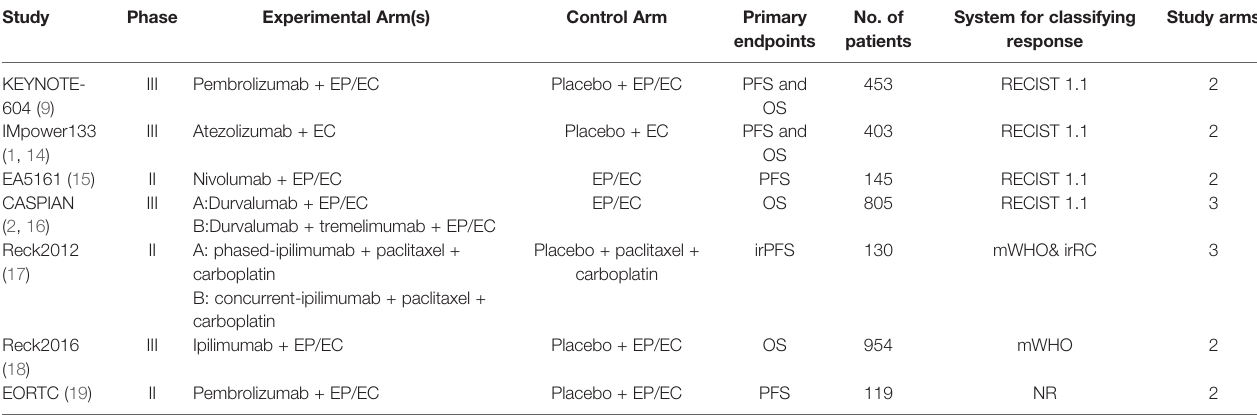
TABLE 1 | Basic information of the included studies.